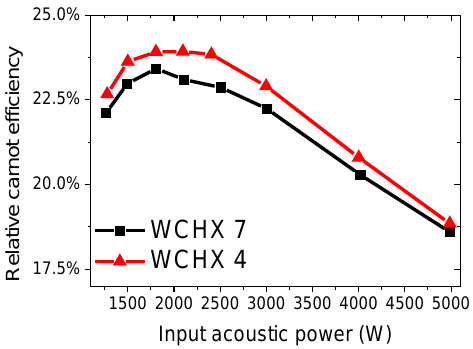
Figure 12. Dependence of relative Carnot efficiency on input acoustic power for WCHXs 4 and 7.